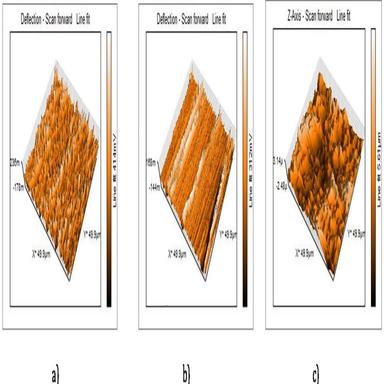
AFM of CS surface a) Surface b) in 1 M H2SO4 c) at 800 ppm of HM in 1 M H2SO4 at 303 K.